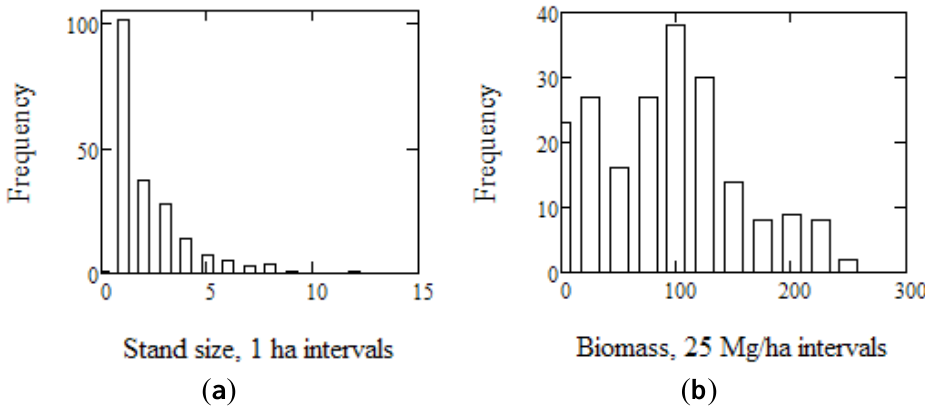
Figure 1. Distribution of forest stand size ( a ) and biomass ( b ) for the 201 forest stands  1 ha at the test site in